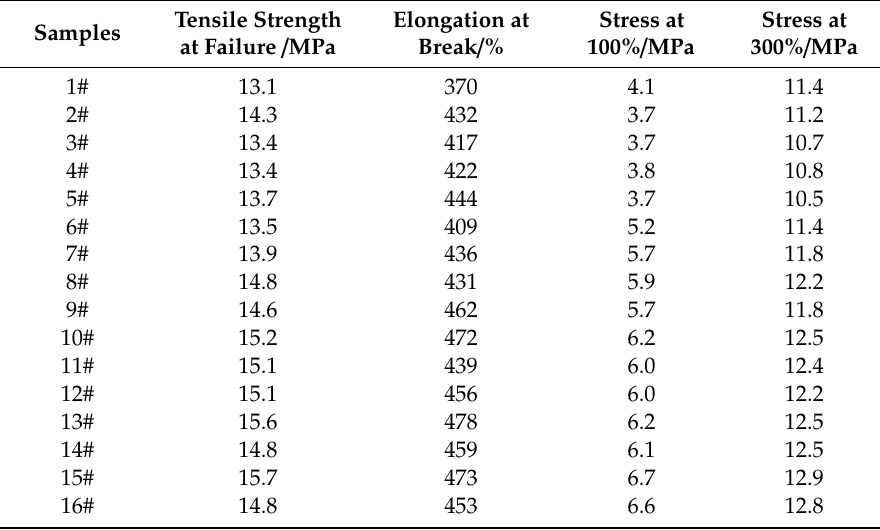
Table 1. Mechanical properties of different samples.